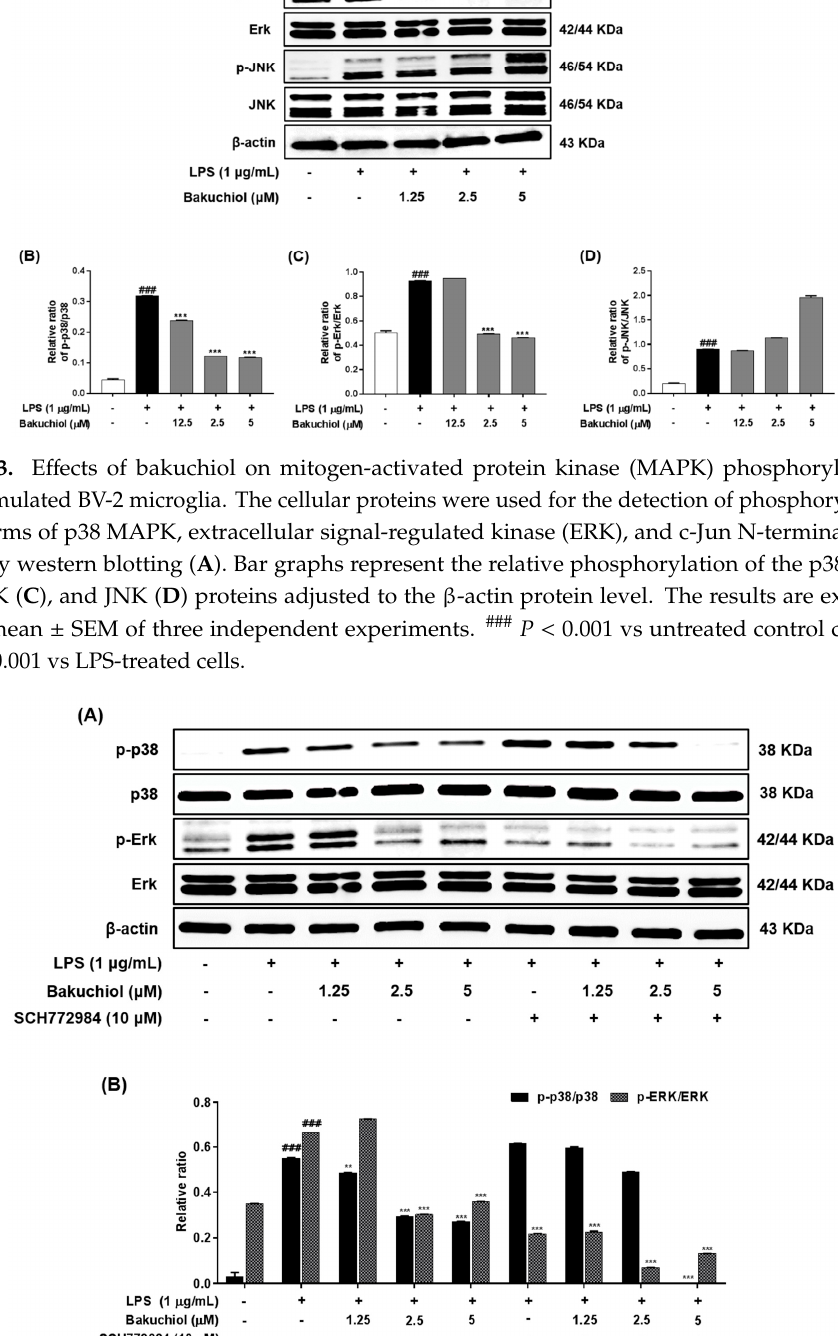
Figure 4. Effects of bakuchiol on p38 MAPK and ERK phosphorylation in LPS-stimulated BV-2 microglia. The cellular proteins were used for the detection of phosphorylated or total forms of p38 MAPK and ERK by western blotting ( A ). Bar graphs represent the relative phosphorylation of the p38 MAPK and ERK ( B ) proteins adjusted to the β -actin protein level. The results are expressed as the mean ± SEM of three independent experiments. ### P < 0.001 vs untreated control cells and ** P < 0.01 or *** P < 0.001 vs LPS-treated cells.